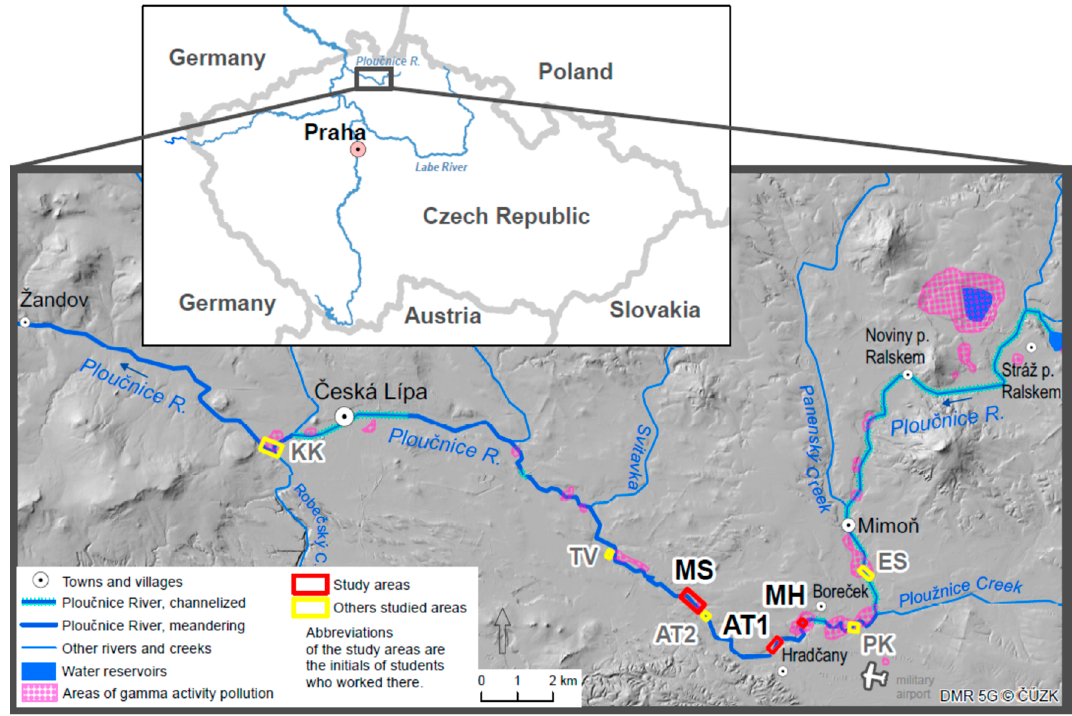
Figure 1. Map of the study areas in this research (red) and other studied areas (yellow). The acronyms of the study sites are the initials of students who worked there.